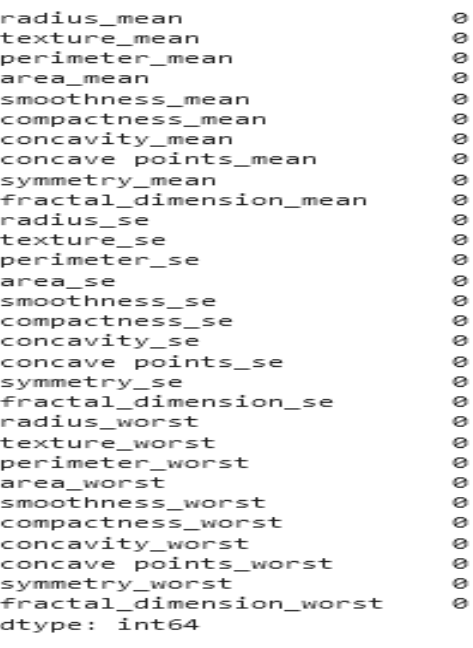
Figure 4. Statistics of the missing values of the datasets features.